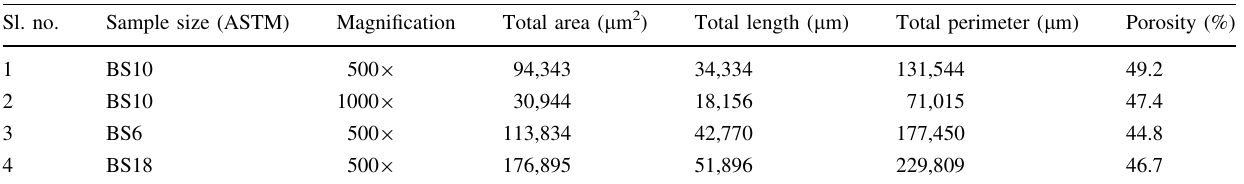
Table 4 Selection of size of coke for preparation of coke pellet number A11 Sl.